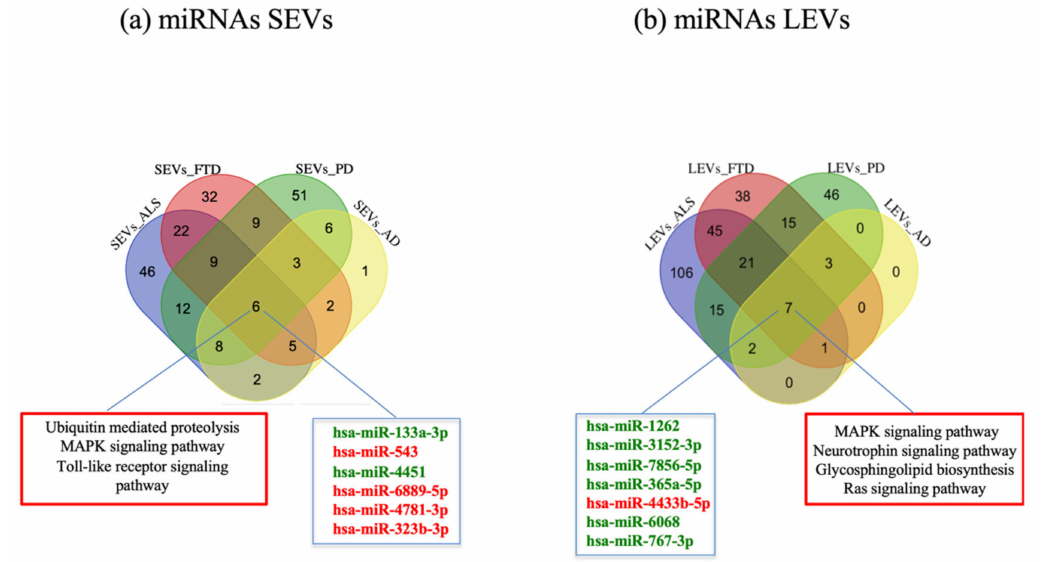
Figure 3. Venn diagram showing numbers of common and unique miRNA and RNA in SEVs ( a ) and LEVs ( b ) from plasma of AD, FTD, ALS and PD patients. Common miRNAs and pathways are listed. Differential miRNA expression analysis by edgeR (log2FC > 1, p -value < 0.05). AD = Alzheimer Disease; FTD = Fronto-Temporal Dementia; ALS = Amyotrophic Lateral Sclerosis; PD = Parkinson Disease; CTRs = controls; SEVs = small extracellular vesicles; LEVs = large extracellular vesicles; miRNA =